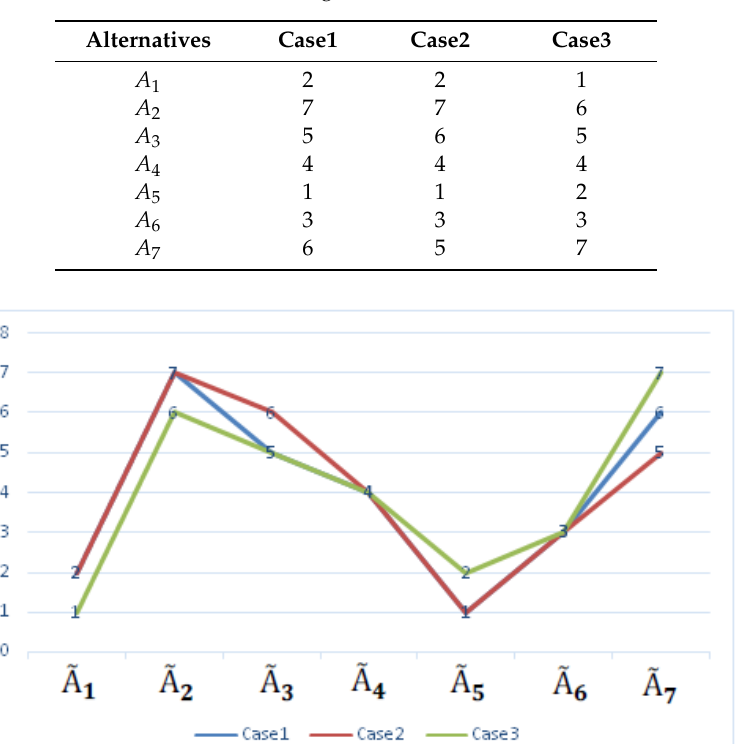
Table 16. Di ff erent Rankings obtained under di ff erent cases.